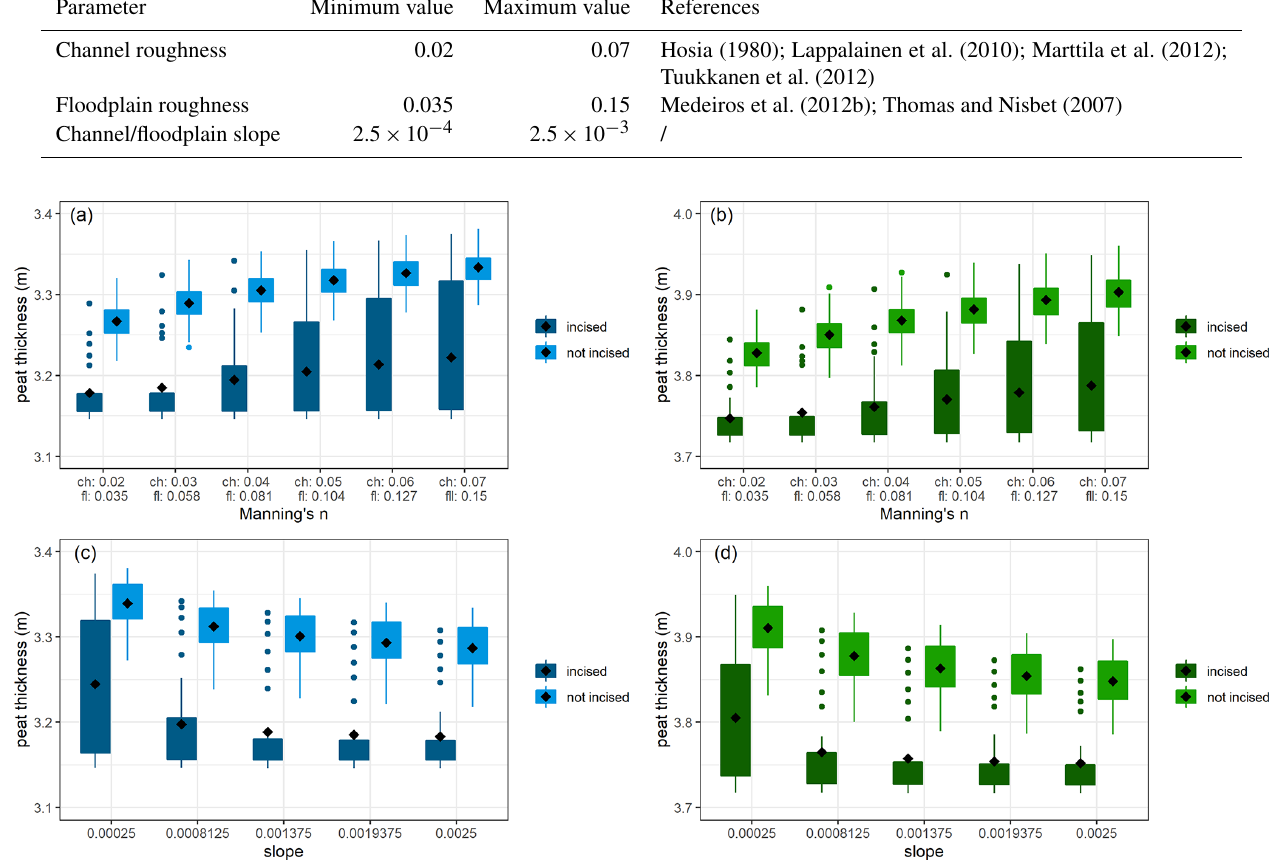
Figure 11. Boxplots of the simulated peat thickness (m) after 10000 years of simulation for the Dijle (a,c) and Grote Nete (b,d) rivers for the different scenarios of channel (ch) and floodplain (fl) roughness coefficients (a,b) and the floodplain and channel slope (c,d) for a floodplain setting with four channels and for the five possible channel dimension scenarios. Each plot divides the results between the scenarios with a rectangular channel incised in the substrate and the scenarios without an incised channel. The mean value is indicated by a black diamond. The box indicates all values within the 25th to 75th percentile range, and the whiskers represent all values within the range from the 25th percentile to 1.5 times the interquartile range to the 75th percentile plus 1.5 times the interquartile range. Coloured dots represent all other values outside this